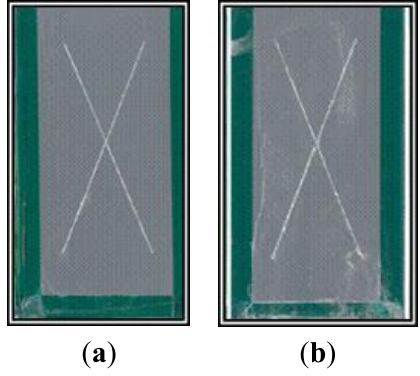
Figure 2 . Photos after 2000 h of NSS exposure testing for ( a ) control; and ( b ) BAM-PPV coated AA2024-T3